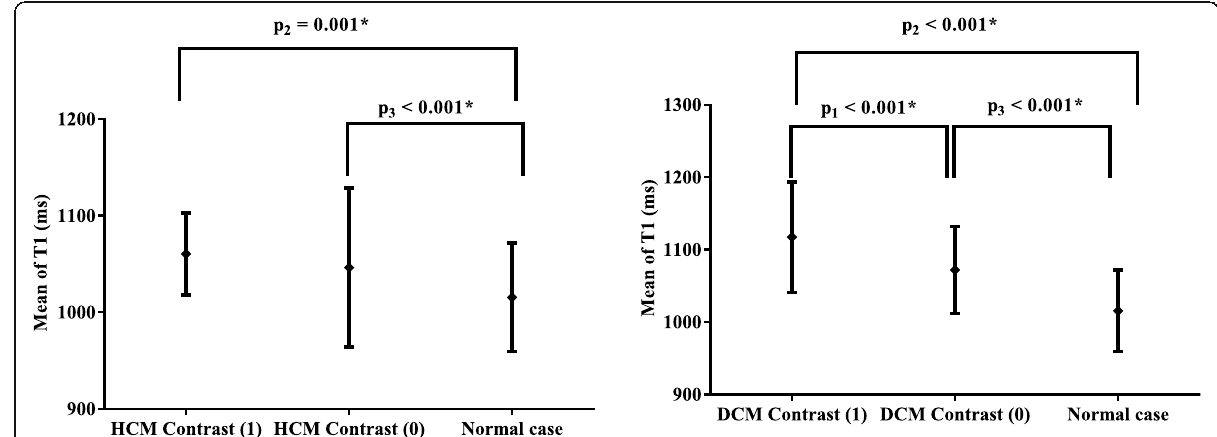
Fig. 7 16 year old male with dilated cardiomyopathy post myocarditis presented with sudden precordial pain like acute myocardial infarction pain, ECG showed ST segment elevation in inferolateral wall (serum creatinine kinease and T-troponin were elevated). a Late gadolinium enhancement (LGE) was found mid wall septal, inferior and inferolateral segments (arrow). b Non-contrast-enhanced T1 mapping shows that the native T1 value of the inferior and inferolateral segments including LGE is 1125 ms, which is more than 1070